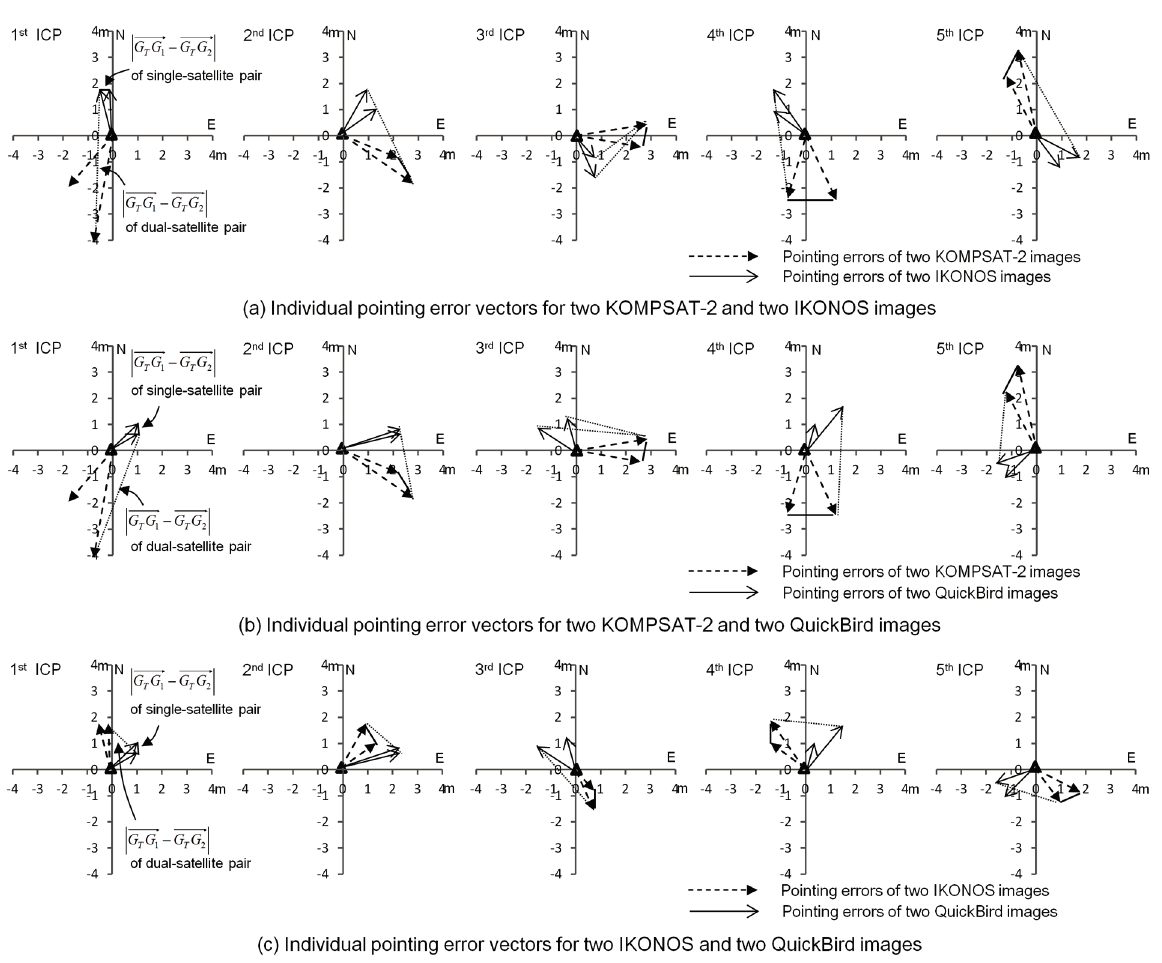
Figure 7. Pointing error vectors and their subtracting vectors for single-satellite stereo and dual-satellite stereo (five ICPs). ( a ) KOMPSAT-2/IKONOS, ( b ) KOMPSAT-2/QuickBird, ( c )